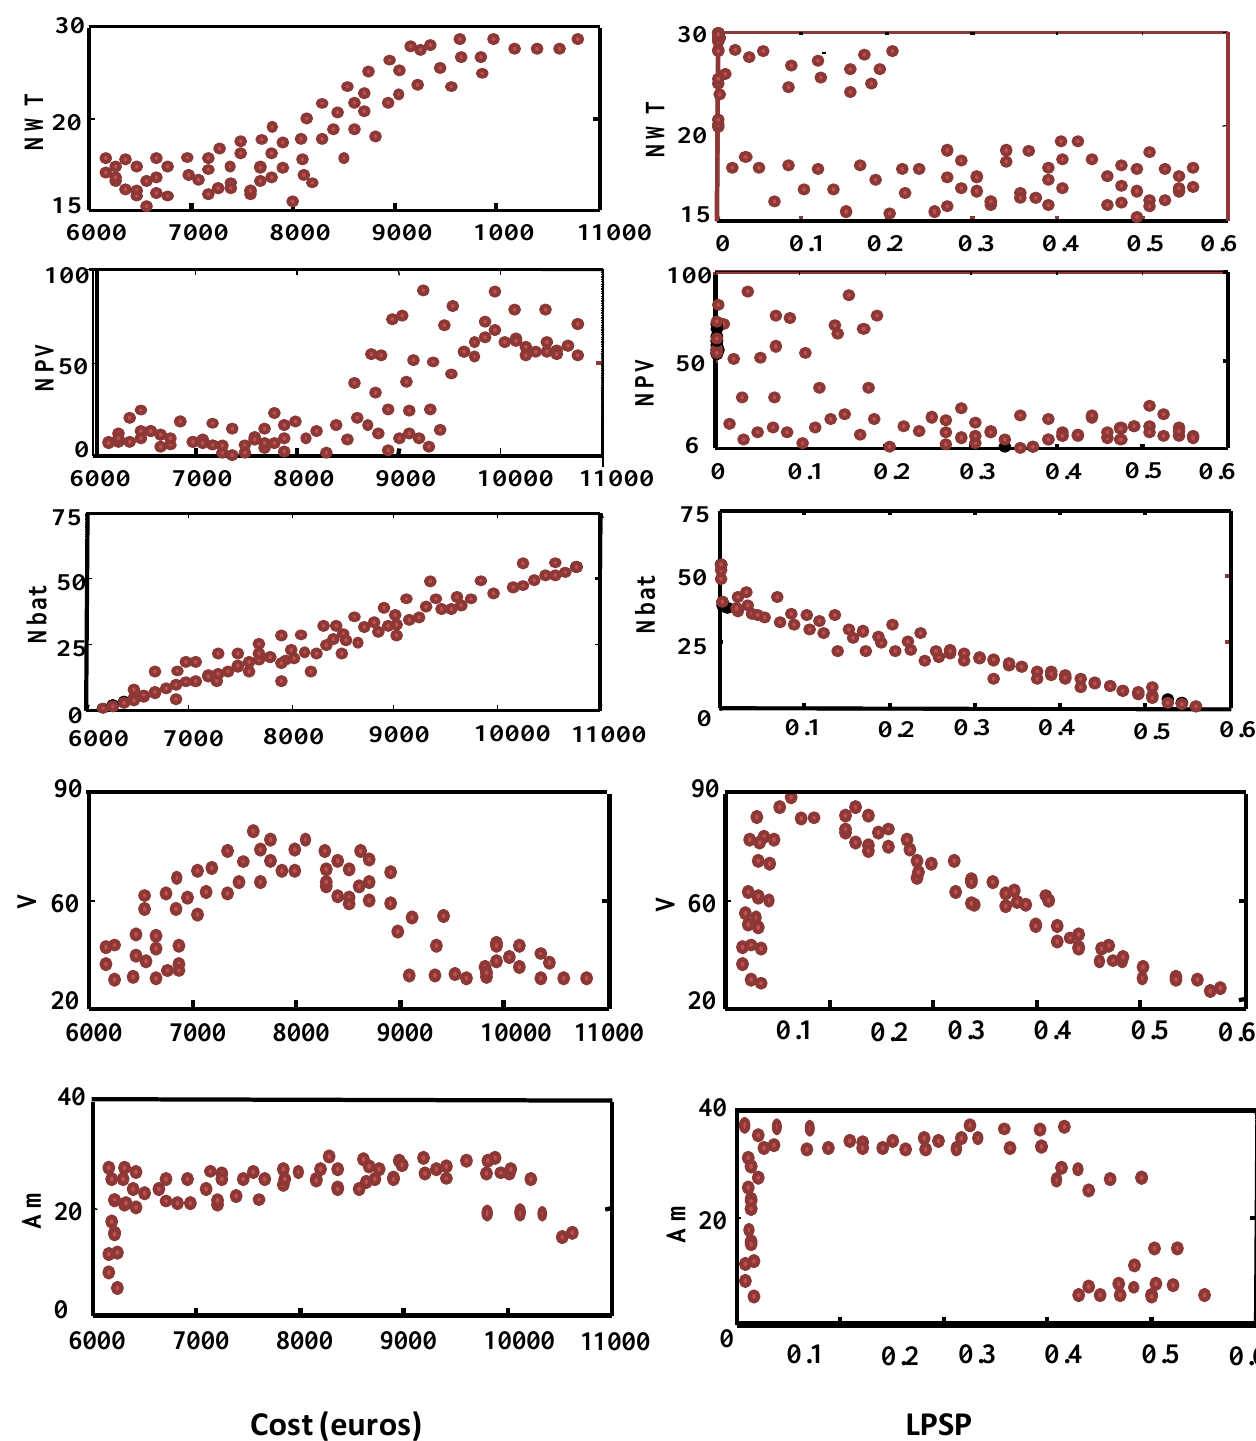
Figure 16. Evolution of design parameters along the optimal front as a function of system cost and as a function of LPSP.